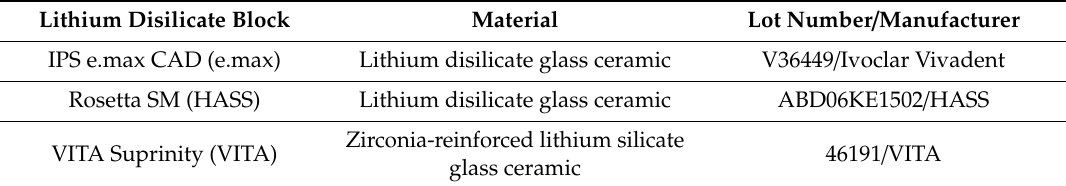
Figure 2. Fabrication of scanned model. ( A ) Crowns fabricated from three types of lithium disilicate block; ( B ) contact scanning procedure. Table 1. Data for lithium disilicate